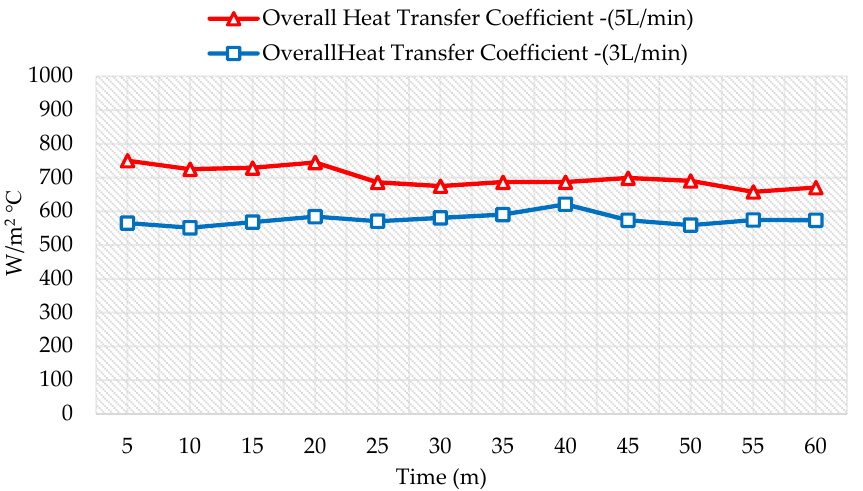
Figure 7. The overall heat transfer coefficient experimentally with different flow rates for the empty channels.